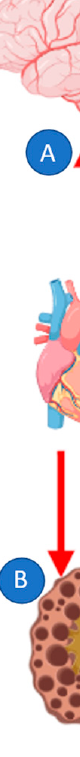
Figure 3. Acute myocardial infarction and heart/brain/kidney axis. ( A ): Ischemic stroke after AMI, driven by increased fibrinogen levels, thromboembolism from left ventricle, and sympathetic activation; ( B ): Kidney injury after AMI, driven by increased ROS and renal tubular damage, hypoperfusion, and systemic inflammation; ( C ): Heart disease in CKD: increased inflammation, ROS production, accumulation of vasoactive uremic toxins, and ER stress.